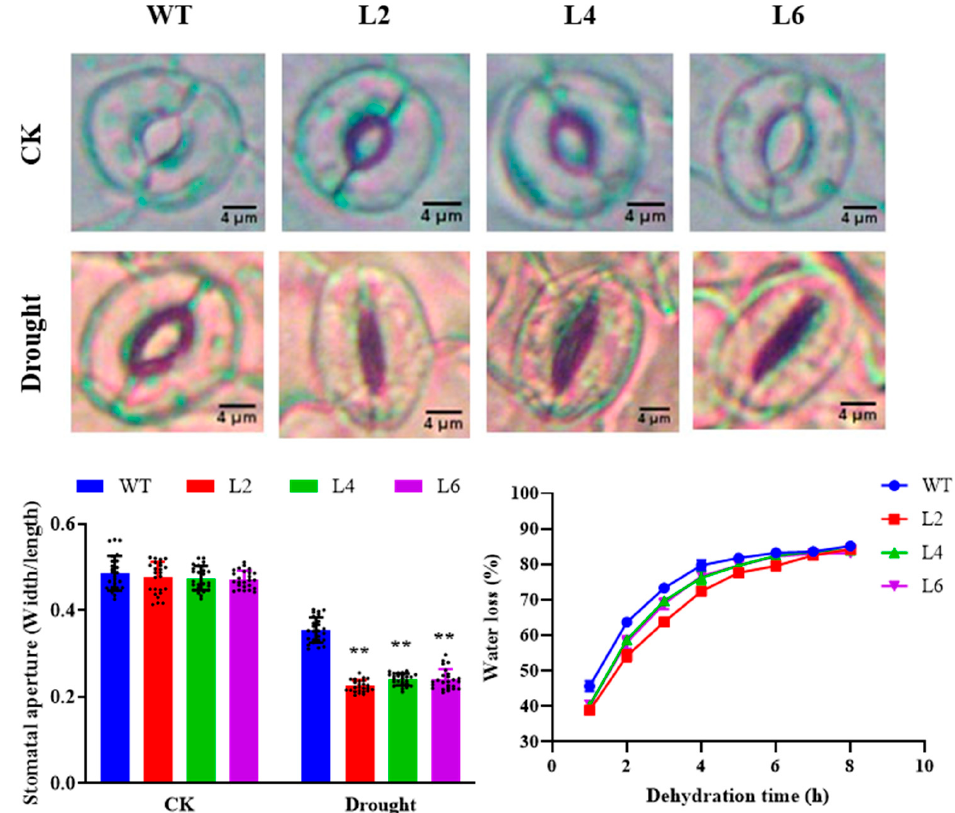
Figure 7. Stomatal aperture and water loss rate of TaPsb28 -overexpressing Arabidopsis seedlings in response to drought stress. The images of stomatal phenotype were obtained by a microscope. Data are expressed as the means ± SDs ( n = 25). “**” indicates statistically significant differences between the plants subjected to the drought and CK treatments at p < 0.01.